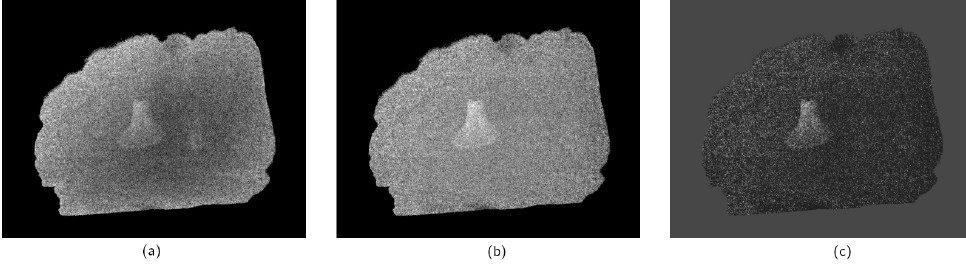
Figure 5. Stages of the scan data pre-processing: R ( x ) computed according to Equation (5) ( a ), R (cid:48) ( x ) defined by Equation (7) ( b ), combined image after correction and normalization computed according to Equation (8) ( c ). The sample is a chicken fillet with a fan bone scanned with an exposure time of 0.5